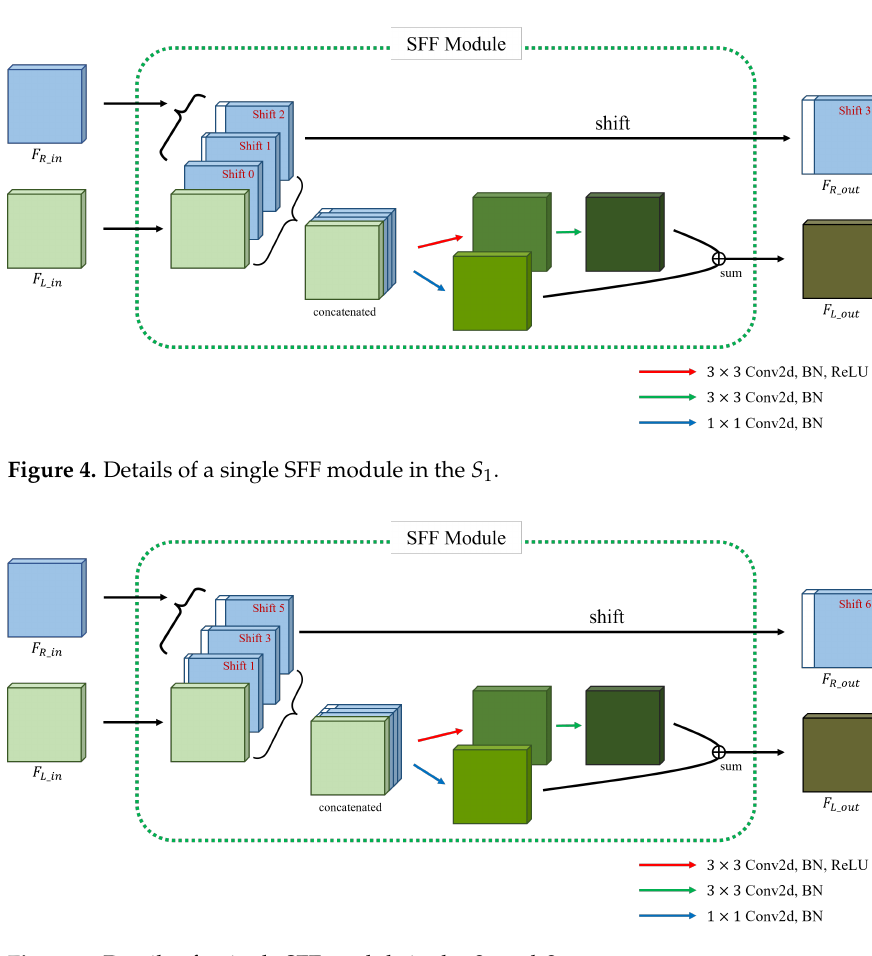
Figure 5. Details of a single SFF module in the S 2 and S 3